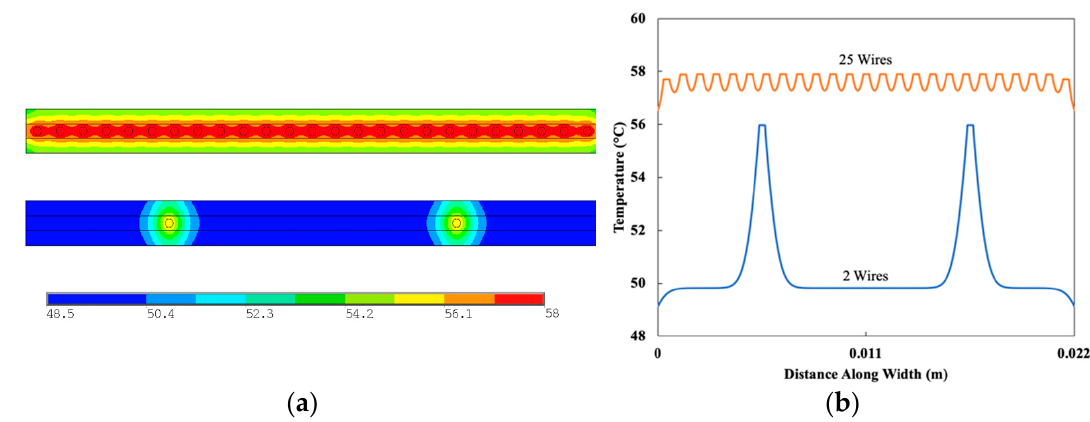
Figure 3. Transient thermal finite element analysis results after 1 s. ( a ) Colormaps for 25-wire configuration (top) and 2-wire configuration (bottom); ( b ) Midplane temperature distribution along width of actuator for 2-wire and 25-wire configurations.